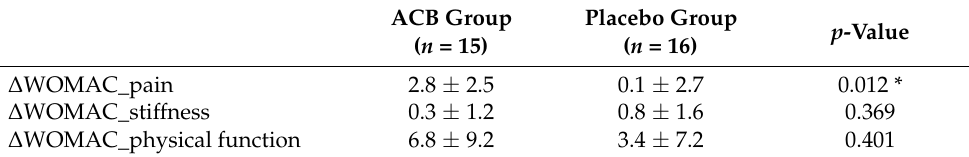
Table 3. WOMAC subscale